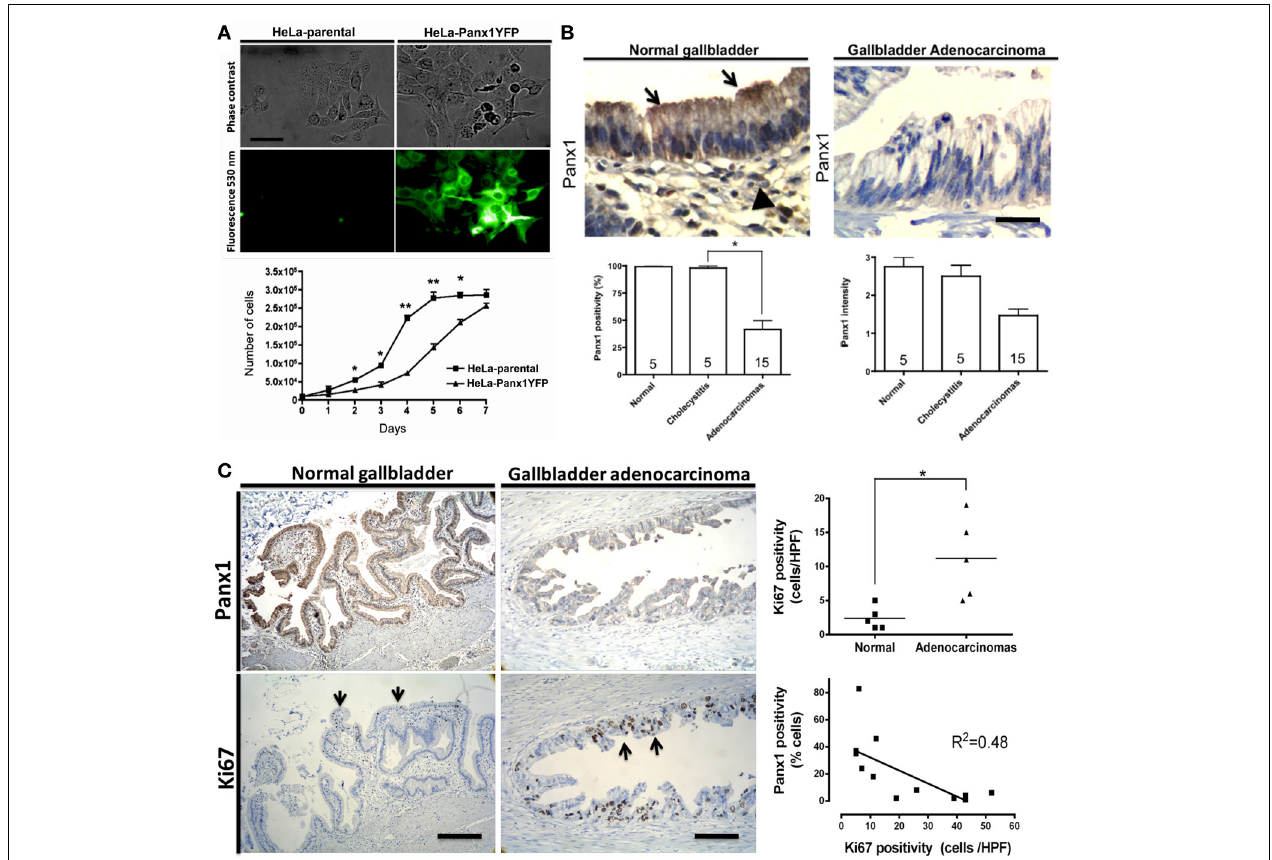
FIGURE 4 | (A) Exogenous Panx1 expression reduces cell density in cultured HeLa cells. Microphotograph showing phase contrast (upper panel) and fluorescence images (lower panel) of cultured parental HeLa cells (left) and HeLa cells stably expressing Panx1-YFP (right, green channel 530nm). Graph showing the cell density of parental (boxes) and Panx1-expressing HeLa cells (triangles) at different days of culture. Cells were exposed to 10% fetal bovine serum and counted each 24h for 7 days. Mean ± s.e.m. of 6 independent experiments is shown. Bar = 30 μ M. (B) Panx1 expression is lower in gallbladder adenocarcinomas. Upper-left panel: Immunohistochemical Panx1 expression using a previously reported antibody (Buvinic et al., 2009) in morphologically normal gallbladder showing positivity in epithelial cells (arrows) and mononuclear inflammatory cells from the lamina propria (arrowheads). Upper-right panel: Panx1 expression in gallbladder adenocarcinoma showing lower Panx1 expression in tumor cells. Lower